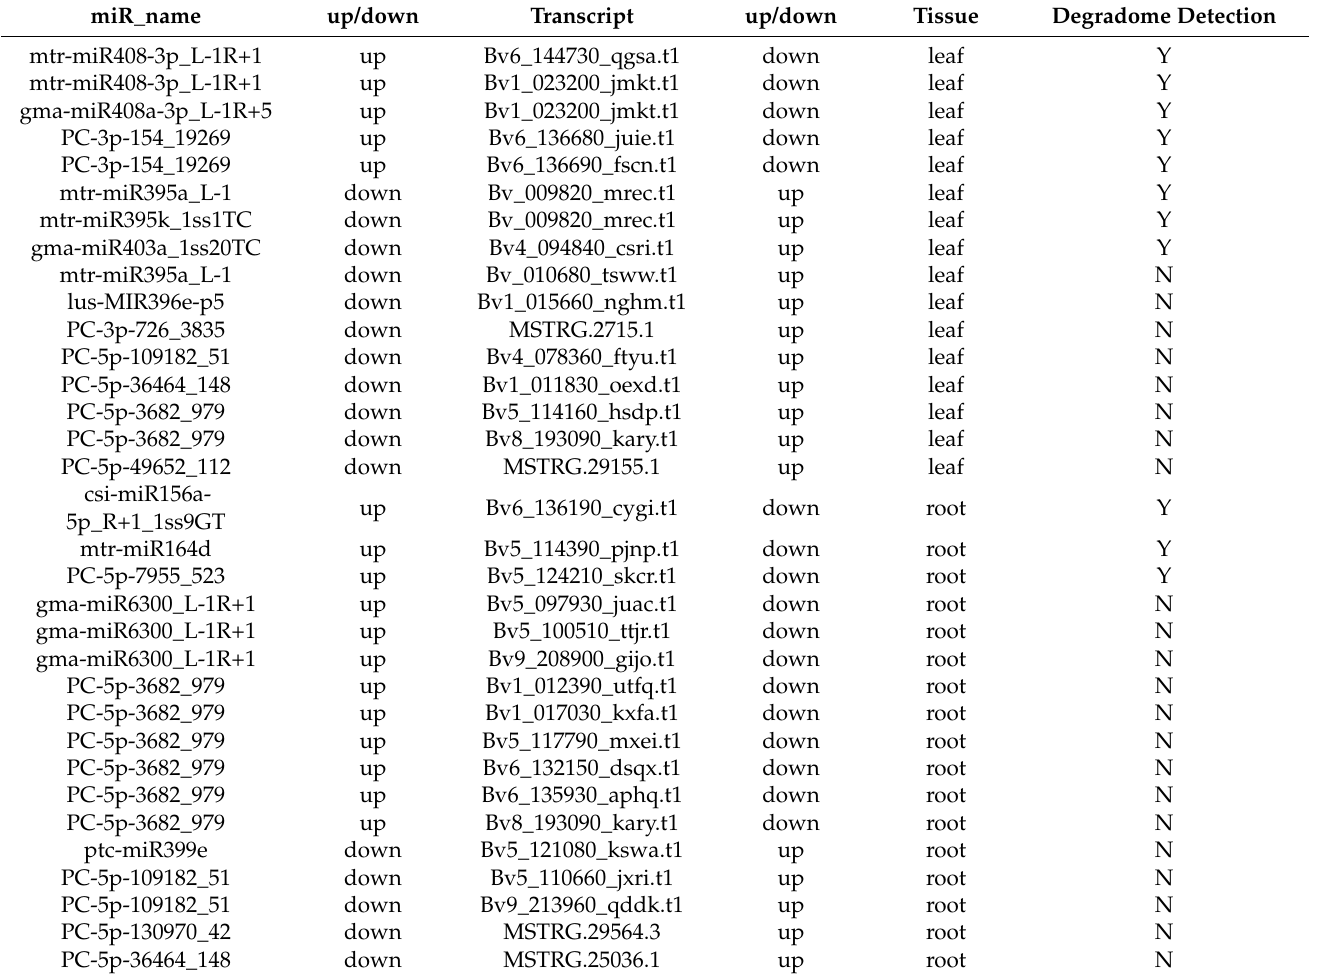
Table 2. Negative regulation DEmiRNA–mRNA pairs in leaves and roots under salt